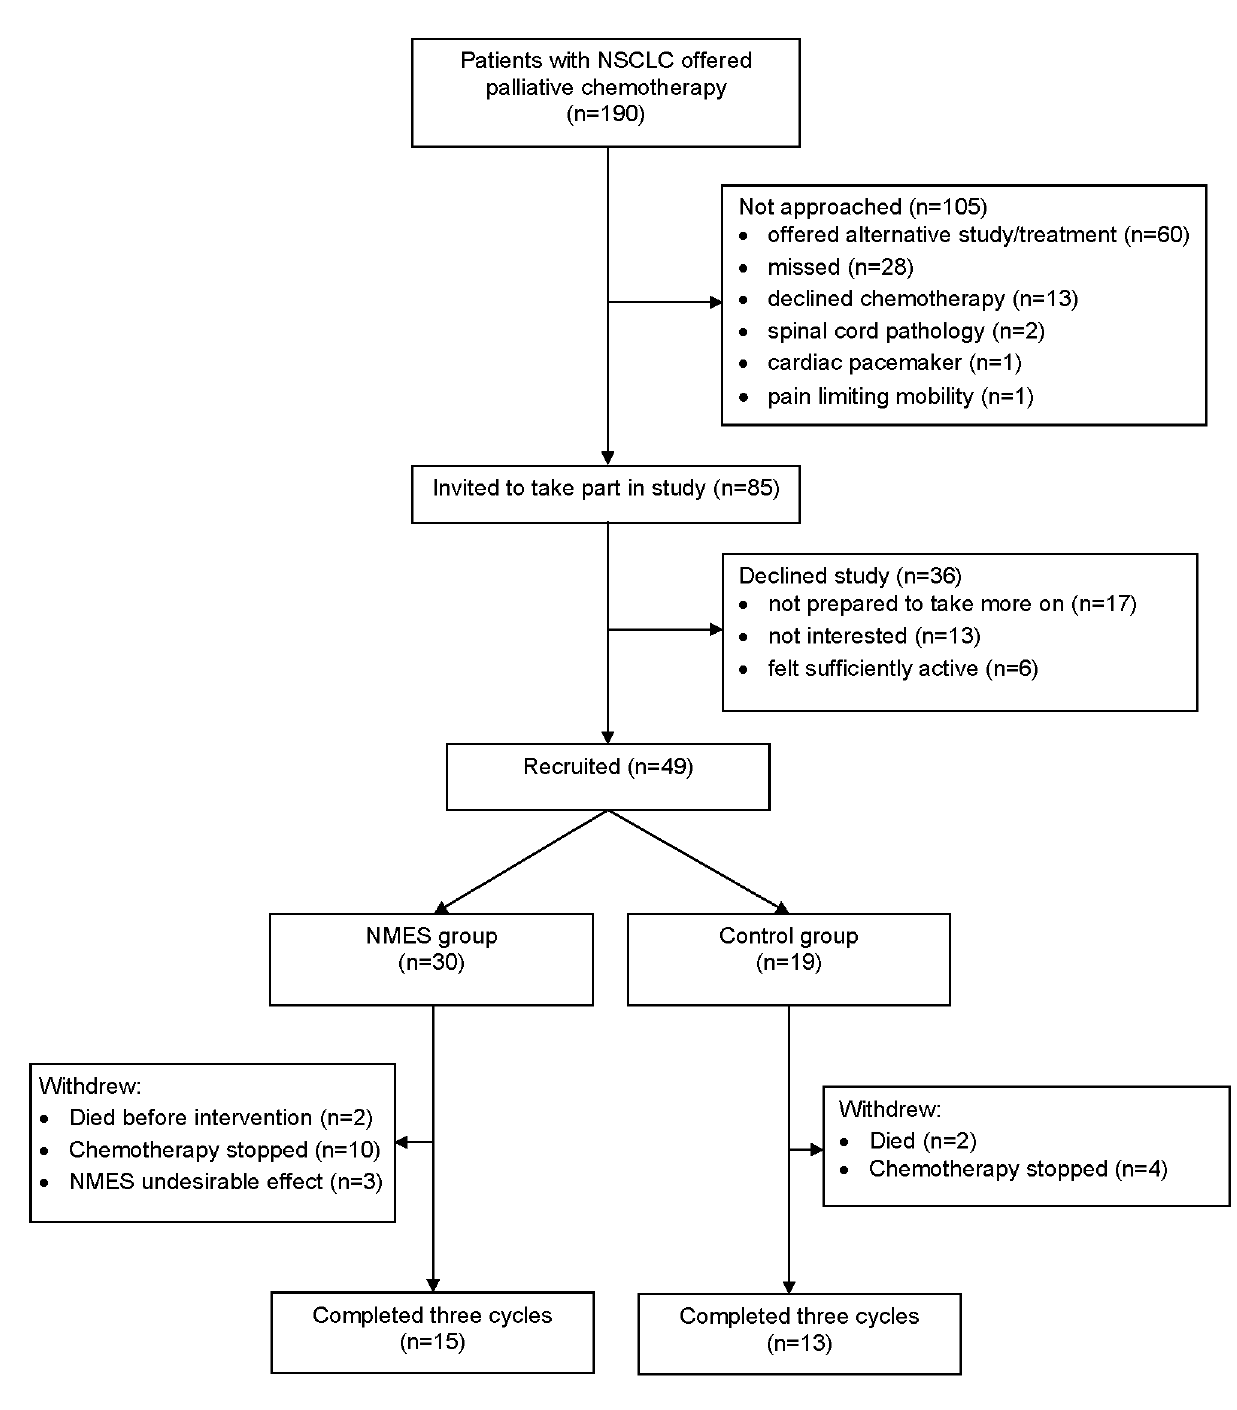
Figure 1. Study flow